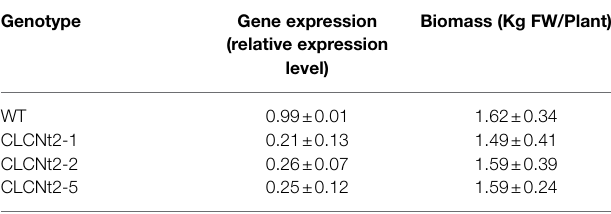
TABLE 1 | qRT-PCR analyses of the CLC-RNAi lines (CLC2-1, CLC2-2, and CLC2-3) compared with the WT